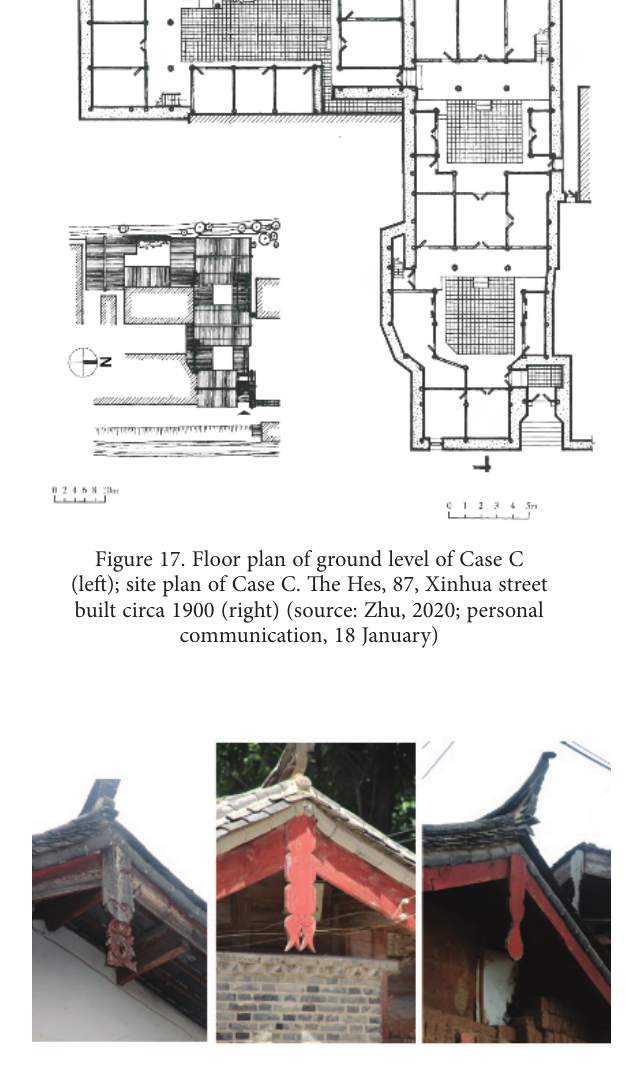
Figure 18. Th e bo ard mimicking fi sh hung beneath the apex (photos by the fi rst author)